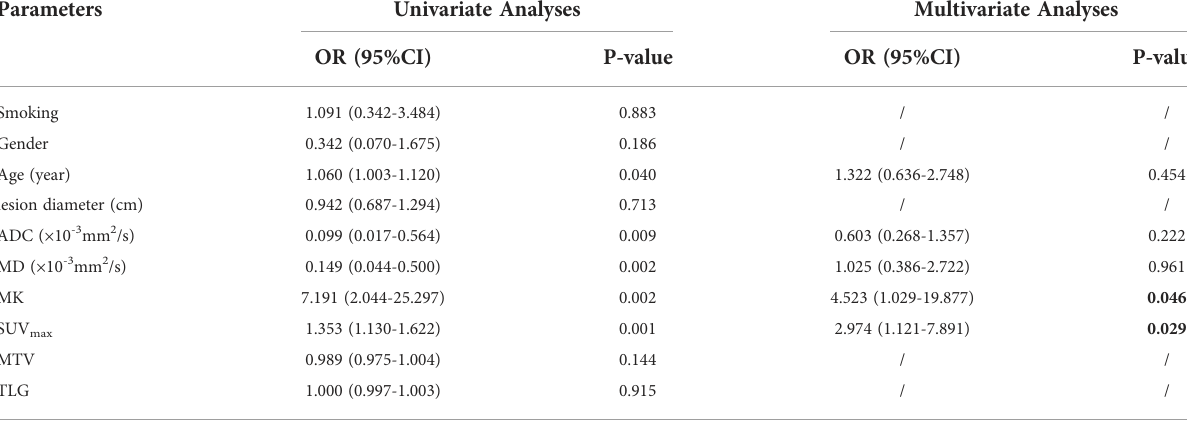
TABLE 3 Univariate and multivariate analysis of differentiating benign and malignant solitary pulmonary lesions. Parameters